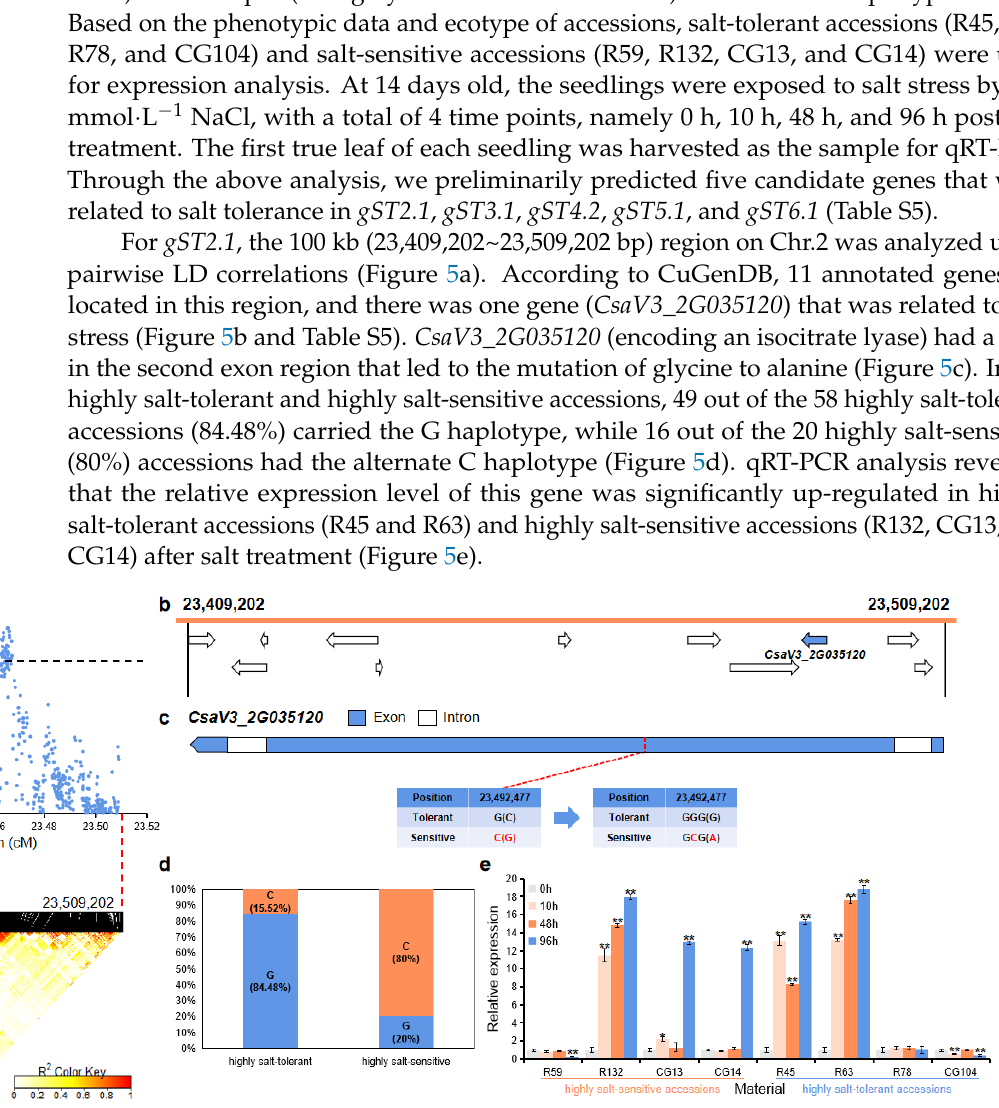
Figure 5. Identification of the candidate gene that was related to salt tolerance for the locus gST2.1 . ( a ) Manhattan plot and LD heatmap of gST2.1 . The black dashed line represents the significance threshold and the red dashed lines represent the candidate region (100 kb). ( b ) A total of 11 functional annotated genes were predicted in the gST2.1 candidate region. The blue arrow indicates that the functional annotation of the gene which is related to salt tolerance. ( c ) Gene structure of CsaV3_2G035120 . Blue rectangles and white rectangles indicate exons and introns, respectively. ( d ) Orange and blue blocks represent the proportion of C and G haplotype in highly salt-tolerant or highly salt-sensitive accessions, respectively. ( e ) qRT-PCR was used to detect the expression changes of CsaV3_2G035120 in highly salt-sensitive accessions (R59, R132, CG13 and CG14) and highly salt-tolerant accessions (R45, R63, R78 and CG104) after salt treatment (0 h, 10 h, 48 h and 96 h). Significant difference (* p < 0.05, ** p <